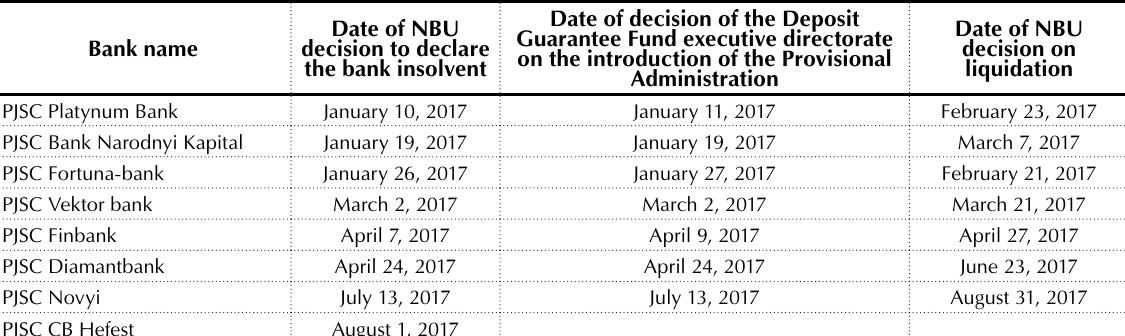
Table 2. Ukrainian banks, which are in reorganization and liquidation as of January 1, 2017 Source: Compiled by the authors based on the NBU statistical